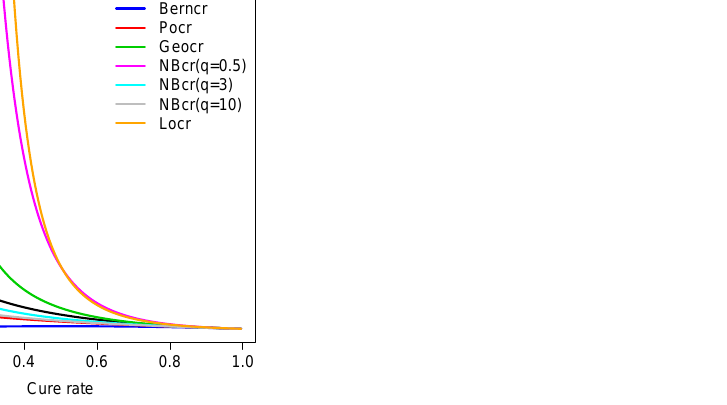
Figure 1. Variance of the number of competing causes as a function of the cure rate for some models. With the parameterization in the cure rate p , the population survival function for